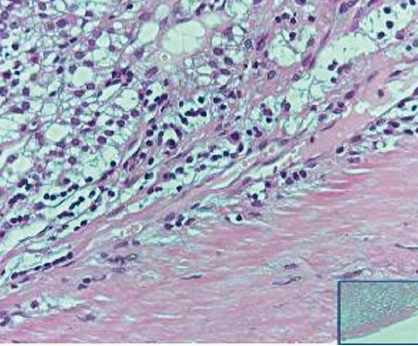
Figure 3: Histological examination (Hematoxilina eosina X60).